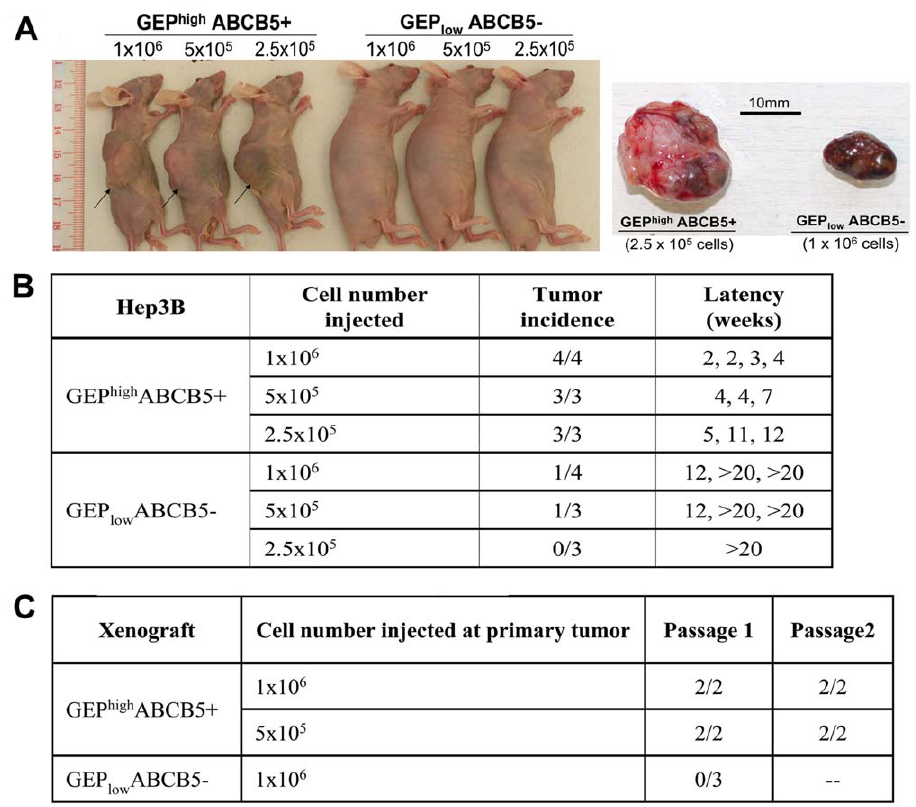
Figure 4. GEP high ABCB5 + Hep3B cells possess enhanced tumorigenic potential invivo . (A) Nude mice injected subcutaneously with GEP high ABCB5 + and GEP low ABCB5 2 cells after 8 weeks. The right panel shows the subcutaneous tumors derived from 2.5 6 10 5 GEP high ABCB5 + and 1 6 10 6 GEP low ABCB5 2 cells at week 16. (B) Tumorigenicity of GEP high ABCB5 + and GEP low ABCB5 2 cells. (C) Serial transplantation of primary tumors generated from GEP high ABCB5 + and GEP low ABCB5 2 cells.